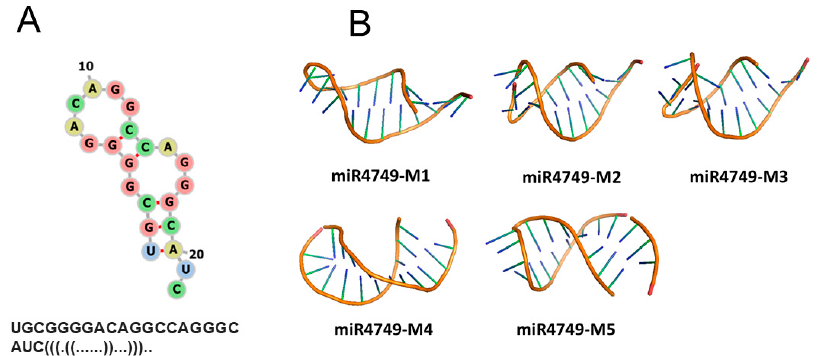
Figure 4. ( A ) Secondary structure of miR4749 together with the dot-bracket representation (bottom). ( B ) Five best models for the 3D structure of miR4749.